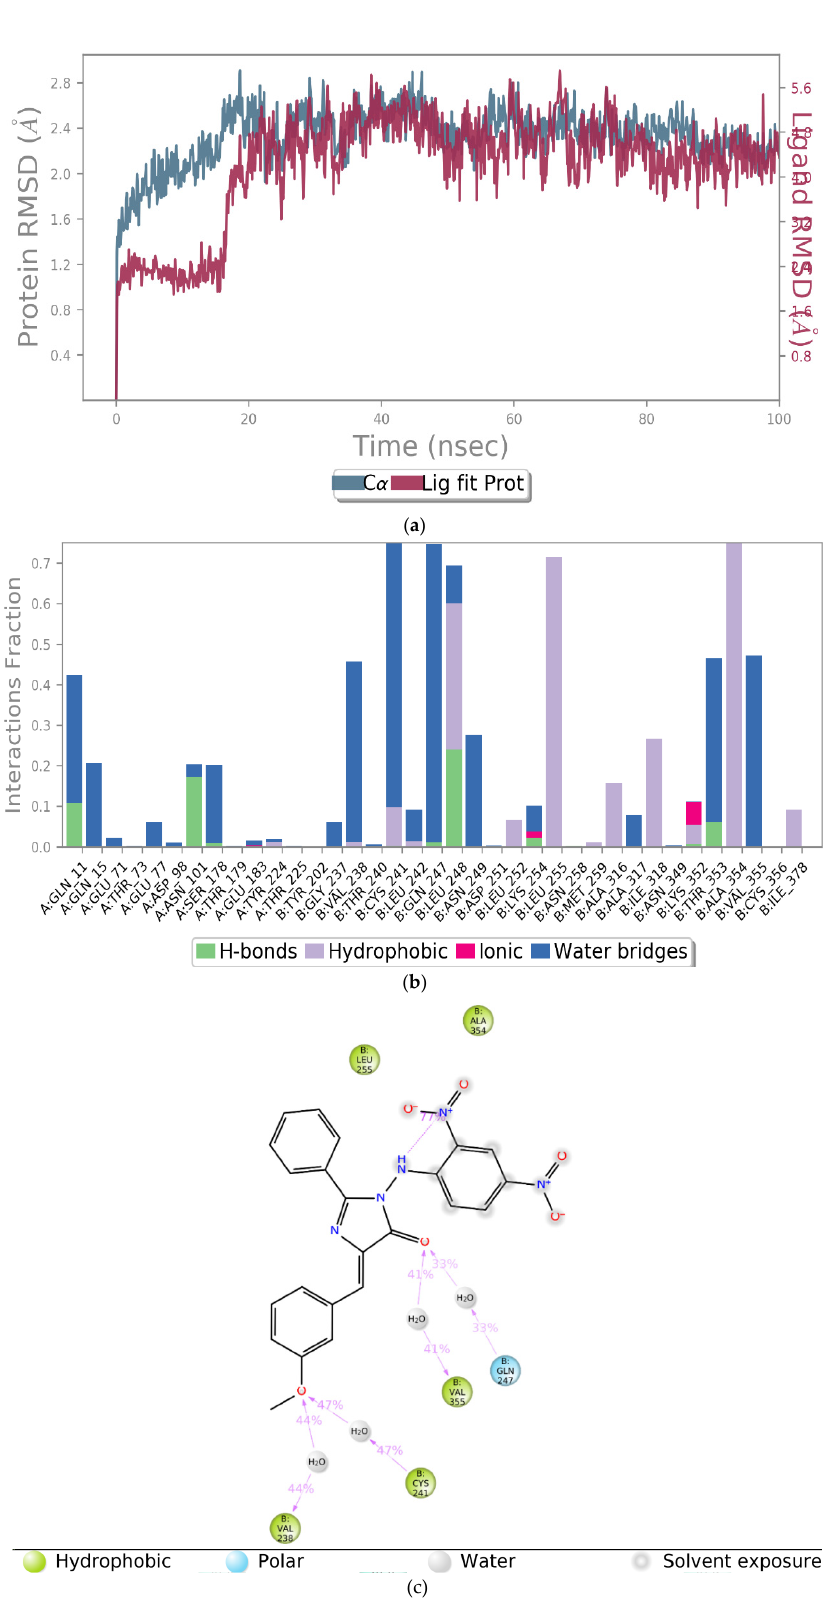
Figure 9. The simulation interaction diagram for compound 9 with the tubulin crystal structure over 100 ns. ( a ) the RMSD values for compound 9 with tubulin for a timescale of 100 ns, ( b ) the amino acid interactions of compound 9 with tubulin for a timescale of 100 ns, and ( c ) the ligand-protein contacts between compound 9 and tubulin crystal structure for a timescale of 100 ns.